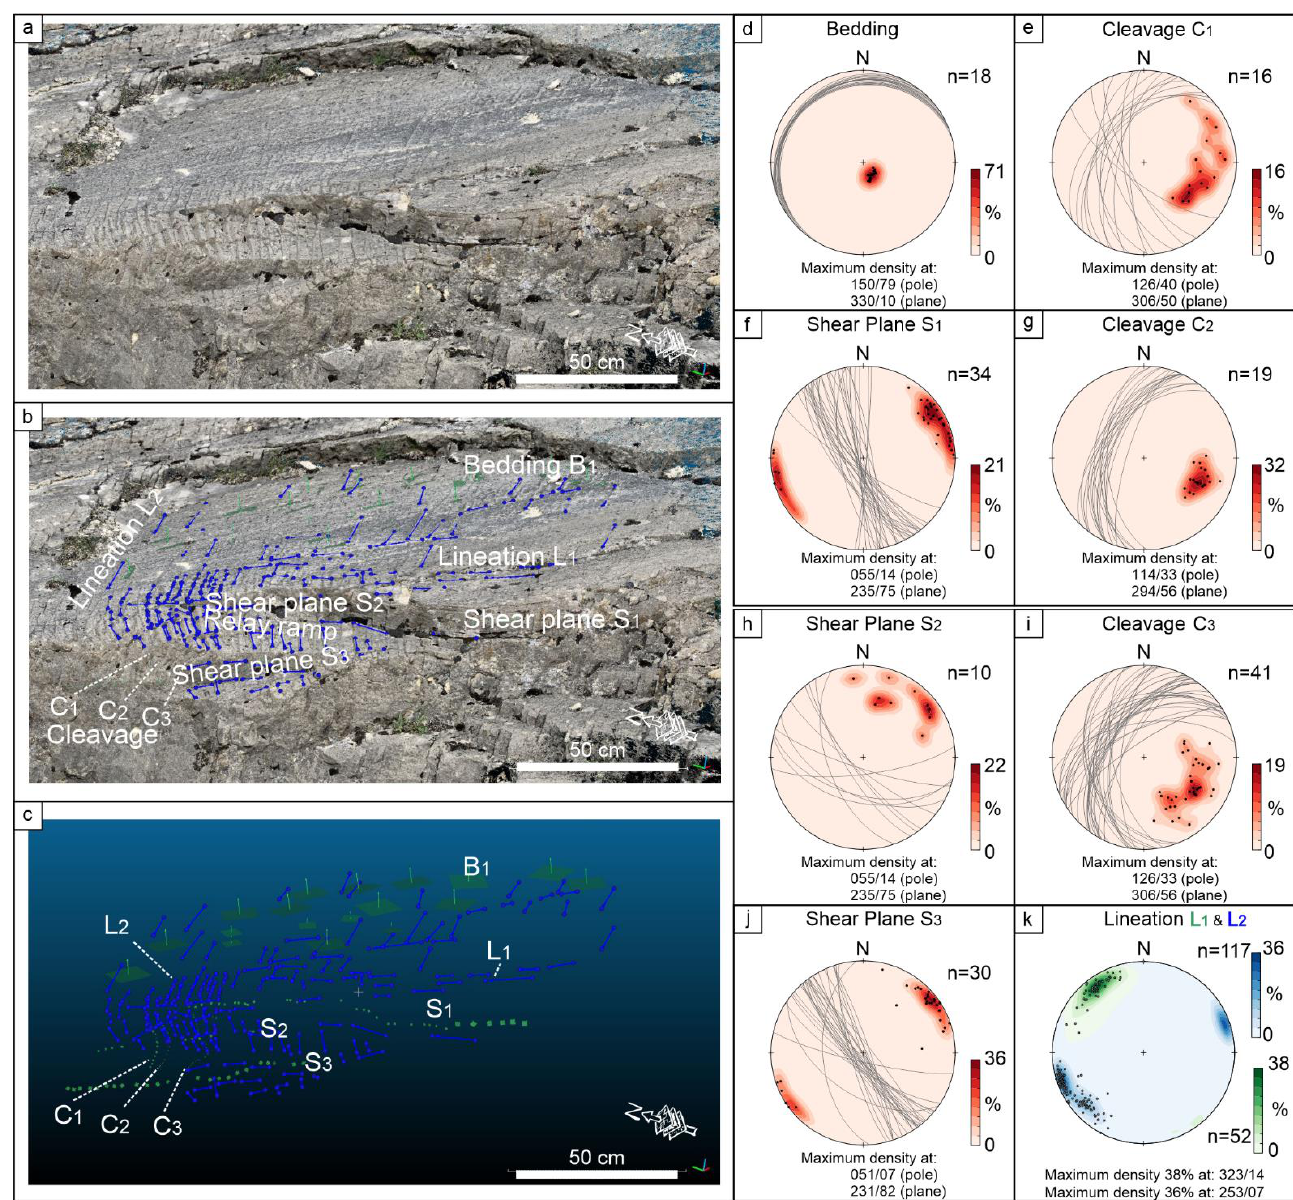
Figure 10. DOM in a portion of sector III of area A (location in Figures 4a,b and 6a). ( a ) Results of an alignment of 68 images with ultra-high quality Agisoft Metashape processing (see Table 1); ( b ) and ( c ) location of measured geological features. In the right panels, stereoplots represent: ( d ) the attitudes of bedding (B); ( e , g , i ) cleavage (C); ( f , h , j ) shear plane (S); ( k ) lineation (L1 = bedding/axial plane cleavage intersection, and L2 = bedding/transecting cleavage intersection); note that in the different sectors of area A (Figure 7a, top-left inset) the bedding attitudes show only slight differences (remaining close to sub-horizontal), which do not cause significant rotation and dispersion of lineations L1 and L2. In the labels at the top of each stereoplot, the subscript number after the letter shows the location of the dataset shown in panel ( c ).